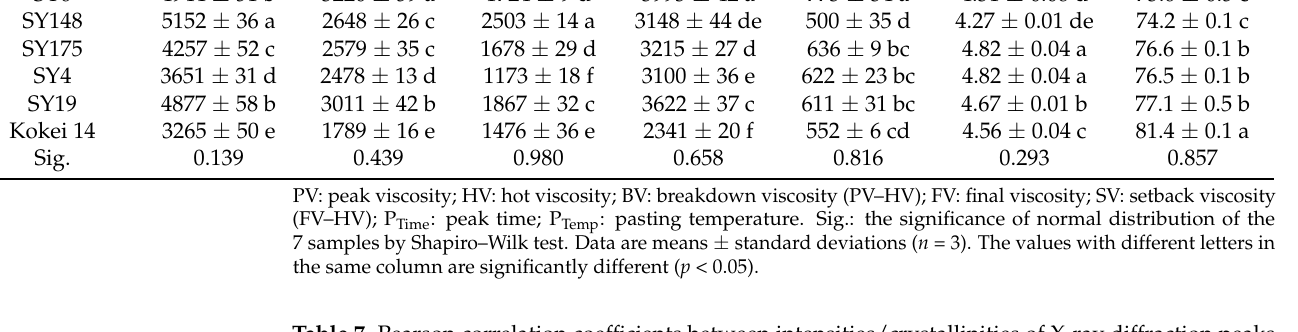
Table 7. Pearson correlation coefficients between intensities/crystallinities of X-ray diffraction peaks and heat properties of C-type